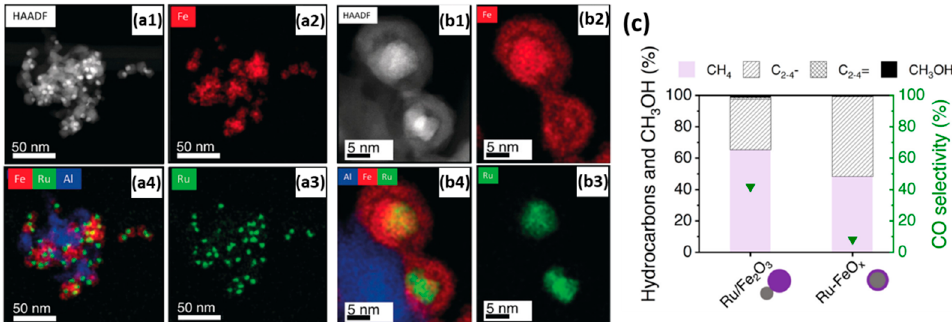
Figure 8. ( a1 ) HAADF-STEM of Al 2 O 3 -supported Ru/Fe 2 O 3 heterodimers after calcination; ( a2 )–( a4 ) corresponding EDX elemental mappings of ( a2 ) Fe, ( a3 ) Ru and ( a4 ) composite Fe, Ru and Al mapping. ( b1 ) HAADF-STEM of Al 2 O 3 -supported heterodimers after reduction by H 2 at 300 °C and subsequent CO 2 hydrogenation; ( b2 )–( b4 ) corresponding EDX elemental mappings of ( b2 ) Fe, ( b3 ) Ru and ( b4 ) composite Fe, Ru and Al mapping. ( c ) Hydrocarbons and MeOH distributions and CO selectivities in CO 2 hydrogenation for heterodimer Ru/Fe 2 O 3 /Al 2 O 3 and core-shell “Ru-FeO x /Al 2 O 3 ” catalysts reduced at 300 ◦ C. Reaction conditions: 25% CO 2 ( V / V ), balance H 2 , T = 300 ◦ C, P = 6 bar, m cat = 30 mg, CO conversion = 18% (Ru / Fe 2 O 3 ), 19% (Ru-FeO x ). Reproduced with permission from Ref. [141]. Copyright 2019 John Wiley and Sons.